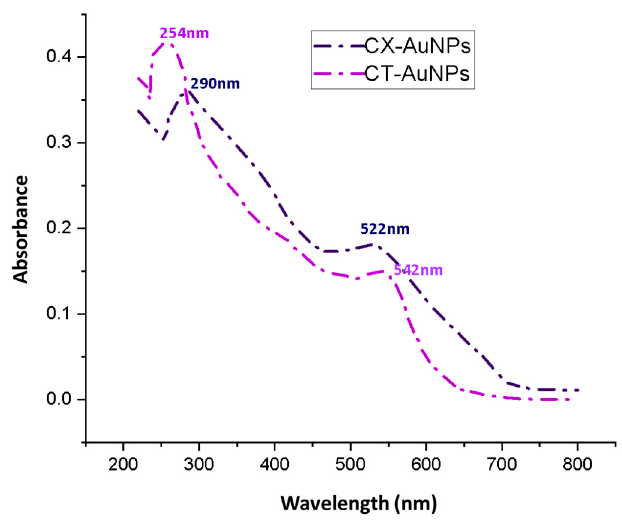
Figure 2. UV-Visible spectrophotometric scan of CX-AuNPs and